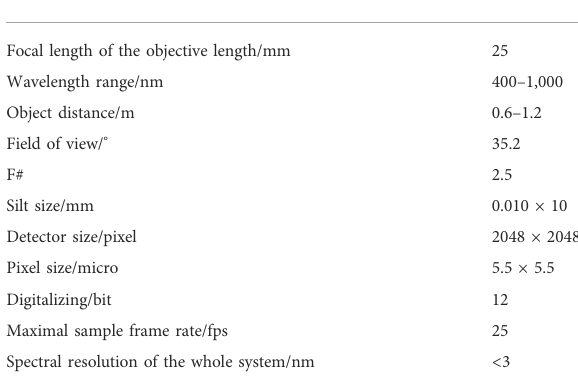
TABLE 1 Design parameters of the optical